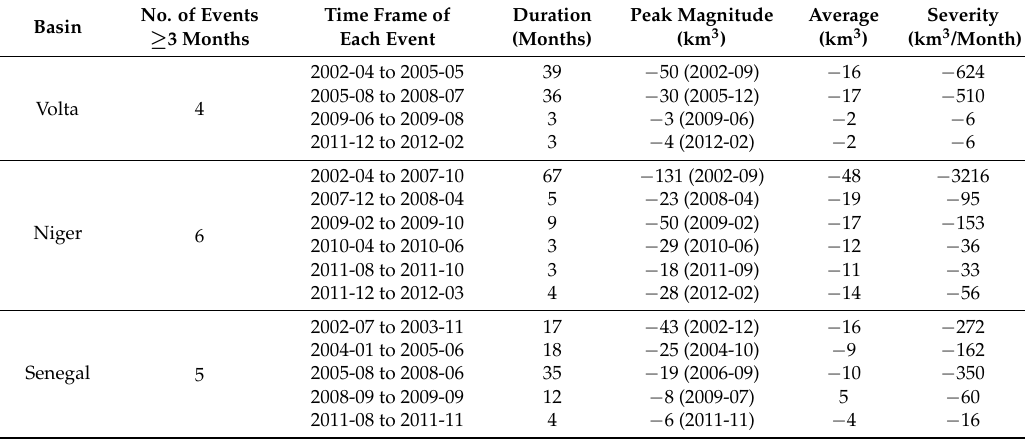
Table 1. A summary of the GRACE–identified hydrological droughts over the major basins of WA.